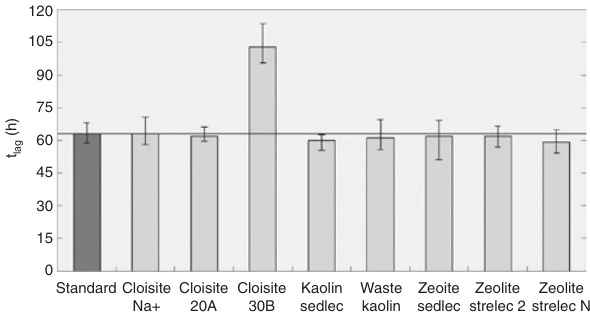
Figure 5: The lag phase during the PVA 88-8 biodegradation with laboratory adapted inoculum in the presence of the selected group of clay minerals ( ± standard deviation).